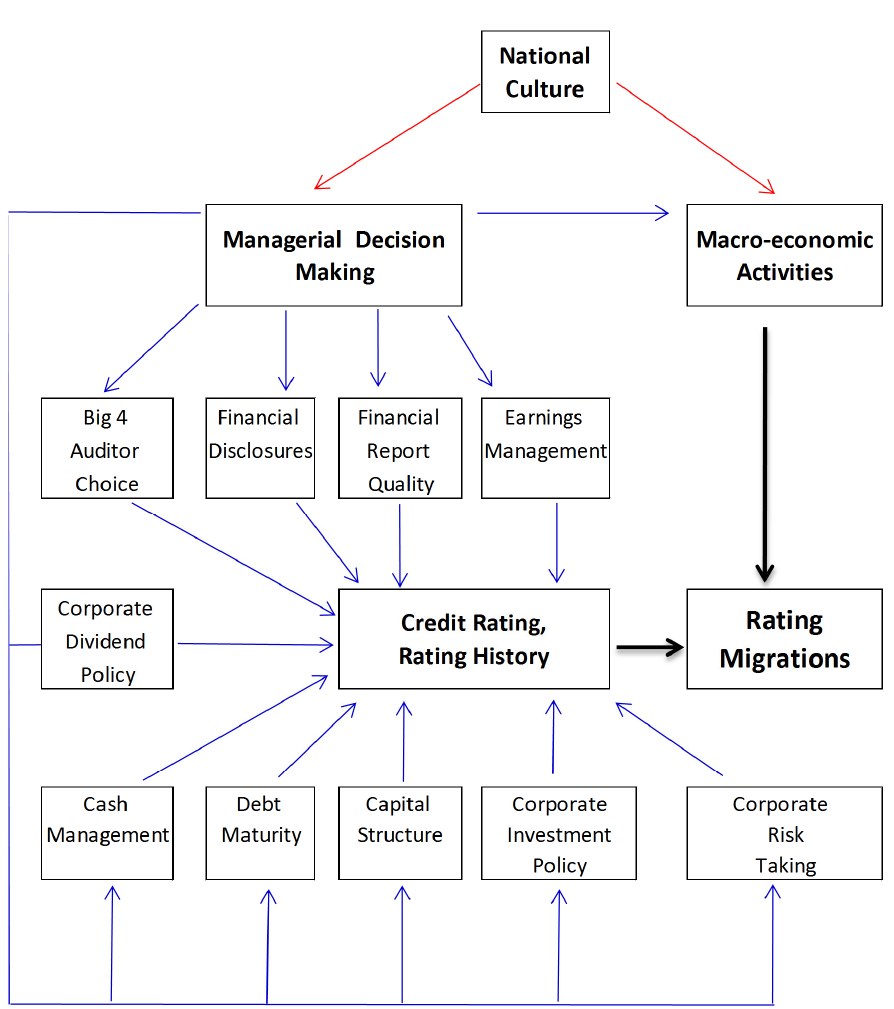
Figure A1. Possible links between national culture and corporate rating migrations.